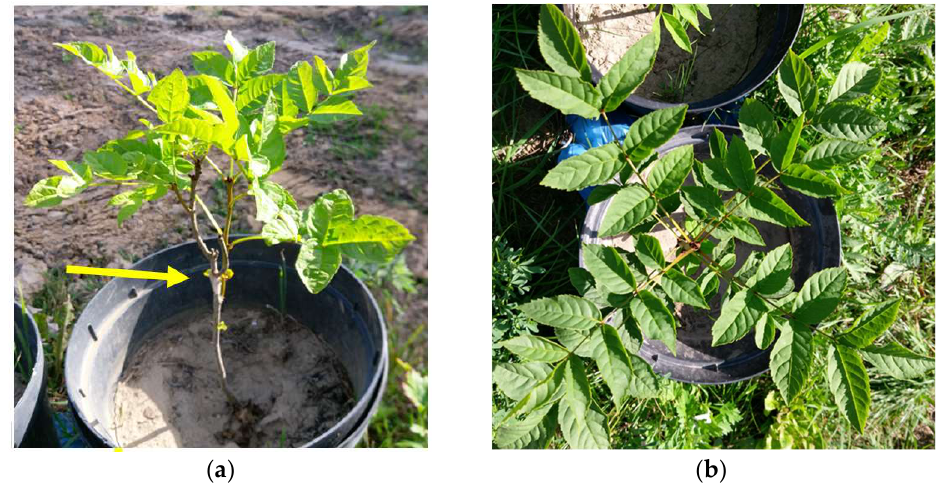
Figure 5. Inoculated saplings showing no symptoms of the disease shown in side view ( a ) and view from above ( b ). Saplings were watered by BTHWA prior to and post inoculation (W1 variant). The arrow indicates the place of inoculation.